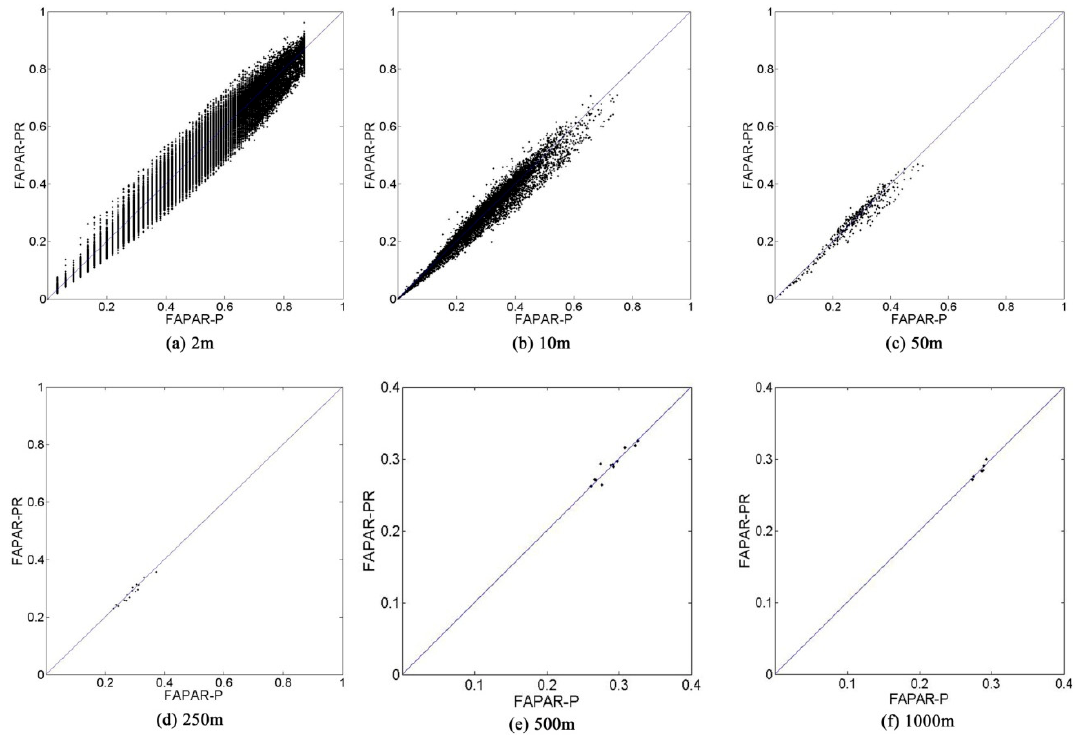
Figure 12. Difference between the FAPAR values at Dayekou calculated using the FAPAR-PR and FAPAR-P models at different scales: ( a ) 2 m; ( b ) 10 m; ( c ) 50 m; ( d ) 250 m; ( e ) 500 m; ( f ) 1000 m.